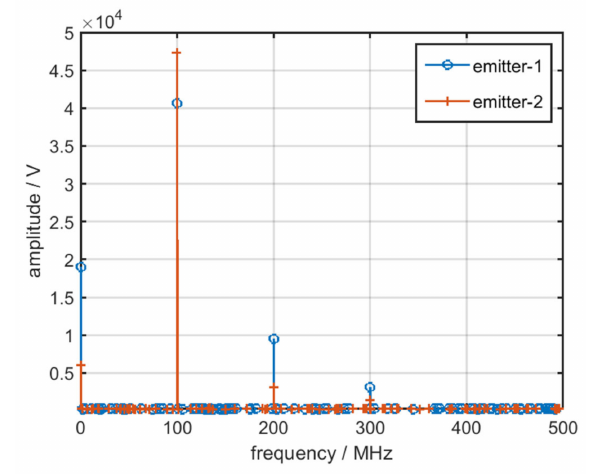
Figure 7. Frequency spectrum of two distinct